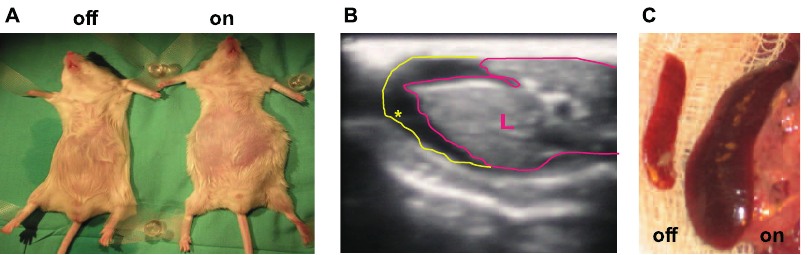
Figure 5. Complications of portal hypertension resulting from sVEGF-R1 expression in the liver. (a) Anesthetized mice showing abdominal distension. ‘on’-sVEGF-R1 expression for one month. (b) Abdominal ultrasonography documenting ascites after one month of sVEGF-R1 expression in the liver. L-liver lined with pink line, ascites (hypoechogenic) is marked by a yellow asterisk and a yellow line. (c) Representative spleens taken from control (‘off’) and after one month of sVEGF-R1 expression (‘on’) in the liver. Average spleen weight is 100 mg and 193 mg in control and transgenic mice, respectively.